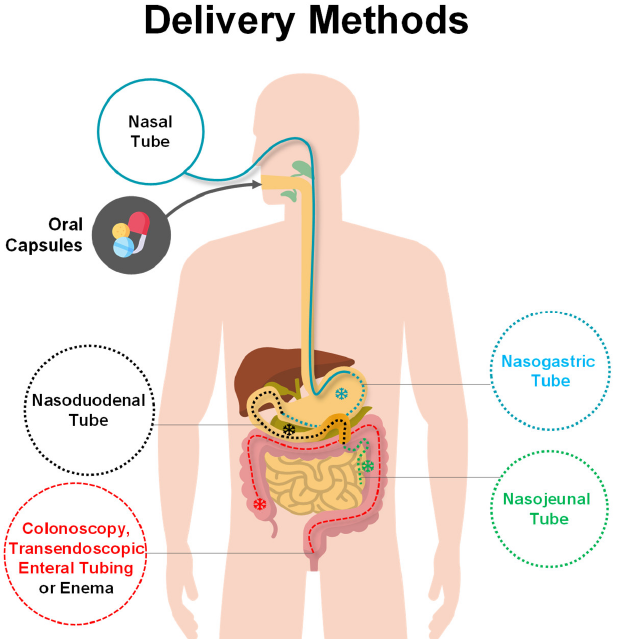
Figure 2. Delivery methods for fecal microbiota transplantation. The delivery methods are classi- fied into upper gastrointestinal routes, including nasogastric/nasoduodenal/nasojejunal tubes and capsules, and lower gastrointestinal routes, including enema colonoscopy and colonic transendo- scopic enteral